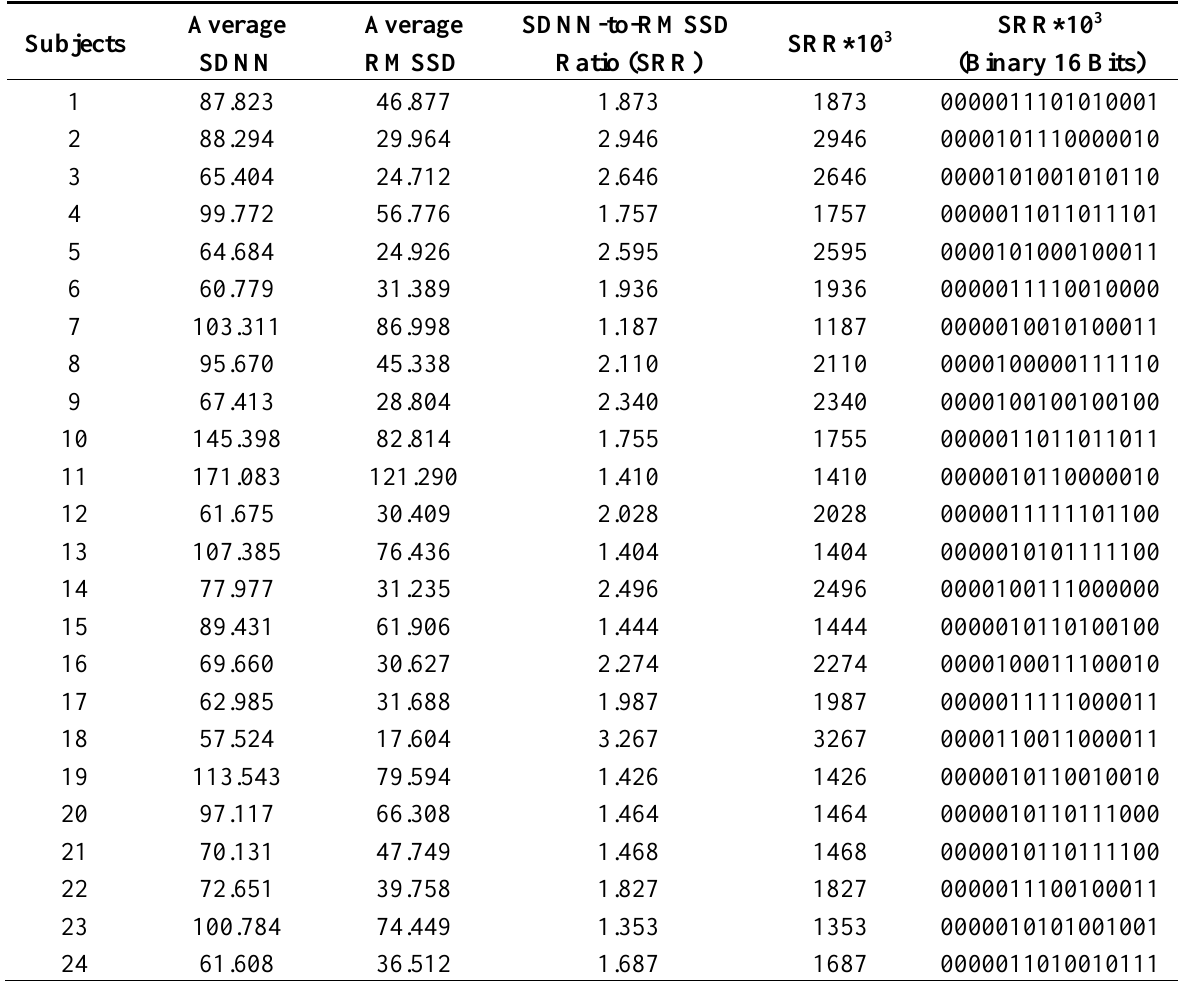
Table 1. The average Standard Deviation of NN interval (SDNN) and average Root-Mean Squared of the Successive Differences (RMSSD), and SDNN-to-RMSSD (SRR) for different